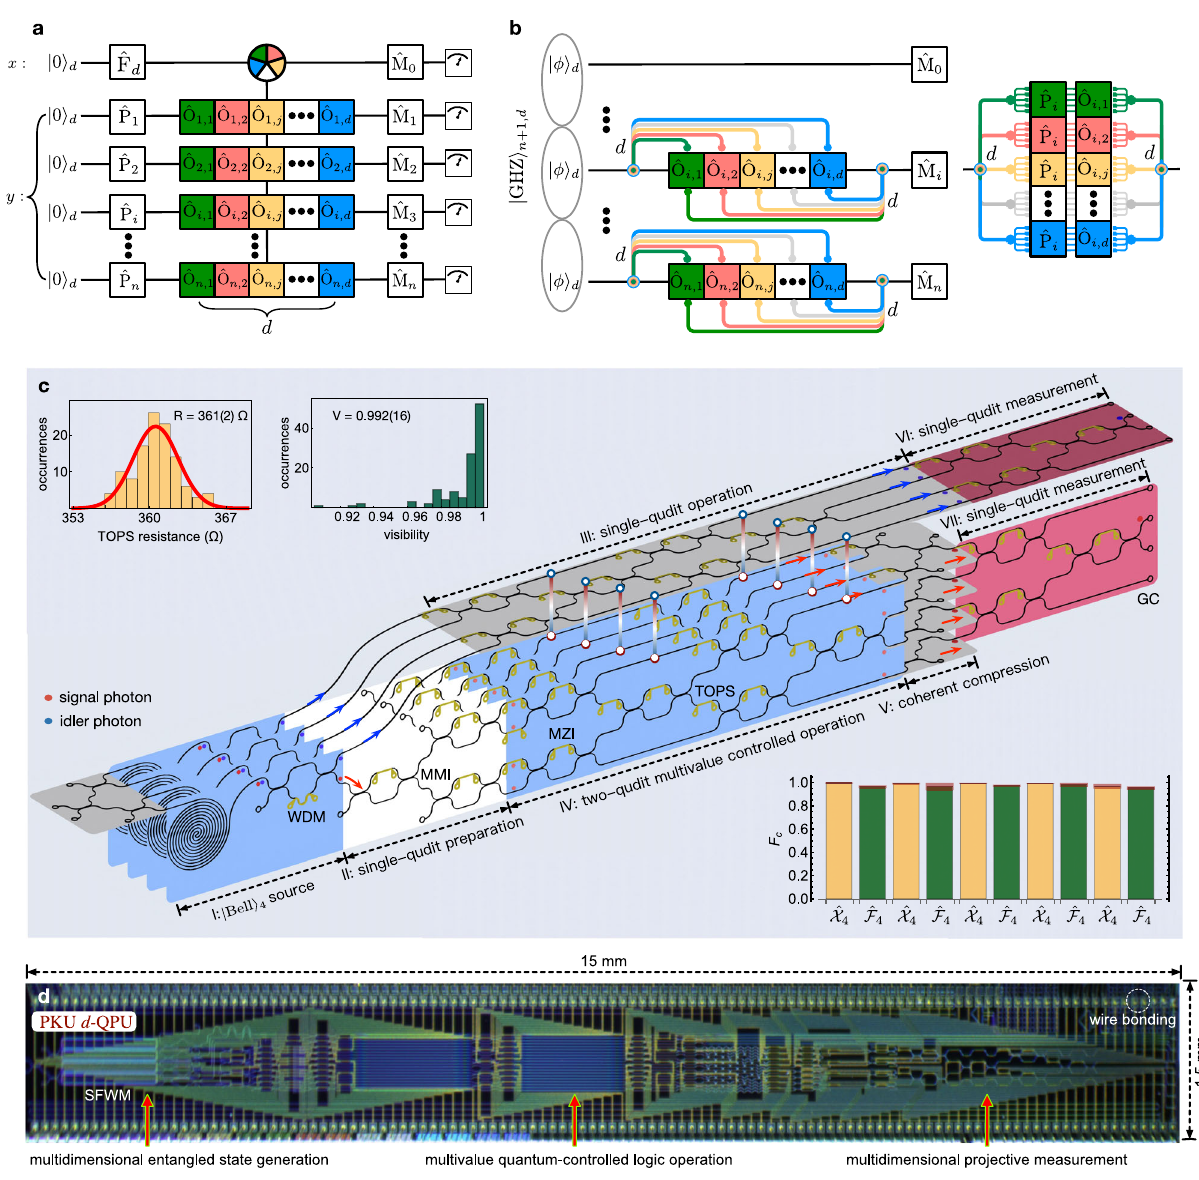
Fig. 2 A qudit-based programmable quantum processing unit in a photonic integrated circuit chip. a Quantum circuit, and b physical implementation of the multiqudit QPU. It bases on multiphoton multidimensional entanglement of GHZ j i n þ 1 ; d , where n + 1 is the number of photonic qudits and d is the local dimensionality of each qudit. Pi is an arbitrary single-qudit gate; F d is a generalised d -level Fourier gate; M i is an arbitrary single-qudit projector; O i , j ( i = 1,..., n , j = 1,..., d ) is an arbitrary single-qudit logic gate that is locally performed on the i -th qudit of the y -register, and the O i , j gates are coherently entangled with the x -register state. The process of “ space expansion--local operation--coherent compression" results in the multiqudit entangling gate, with a success probability of 1/ d , independent on n . c The simpli fi ed schematic of a two-ququart d -QPU: (I) generation of four-level entangled state in an array of four integrated identical SFWM sources; (II) Hilbert space expansion and arbitrary single-qudit preparation of the y -register state; (III) arbitrary single-qudit operation of the x -register state; (IV) arbitrary single-qudit operation (loading in the four layers) of the y -register state, in which the operations are coherently entangled with the x -register state, thus forming the MVCU entangling gate, where the state-gate entanglement is indicated by the four colourful links; (V) coherent compression of Hilbert space by an indistinguishable erasure of spatial information; (VI) and (VII) arbitrary single-qudit projective measurement in the x and y registers. Insets: left top, measured resistance of all thermal-optic phase shifters (TOPSs); measured interference visibility of all 2-dimensional Mach-Zehnder Interferometers (MZIs); bottom right, measured classical statistic fi delities ( F c ) for the Pauli X 4 gate with a mean of 0.988(13) and Fourier F 4 gate with a mean of 0.967(19). d A microscopy image of the d -QPU chip. It monolithically integrates 451 optical components, including 4 SFWM sources, 116 recon fi gurable TOPS, 131 multimode interferometer (MMI) beamsplitters, 4 wavelength-division multiplexing (WDM) fi lters, 156 waveguide crossings and 40 grating couplers (GC). The d -QPU chip is wire bounded and can be fl exibly controlled by classical electronics, and can be reliably reprogrammed and recon fi gured to benchmark a spectrum of different quaternary quantum